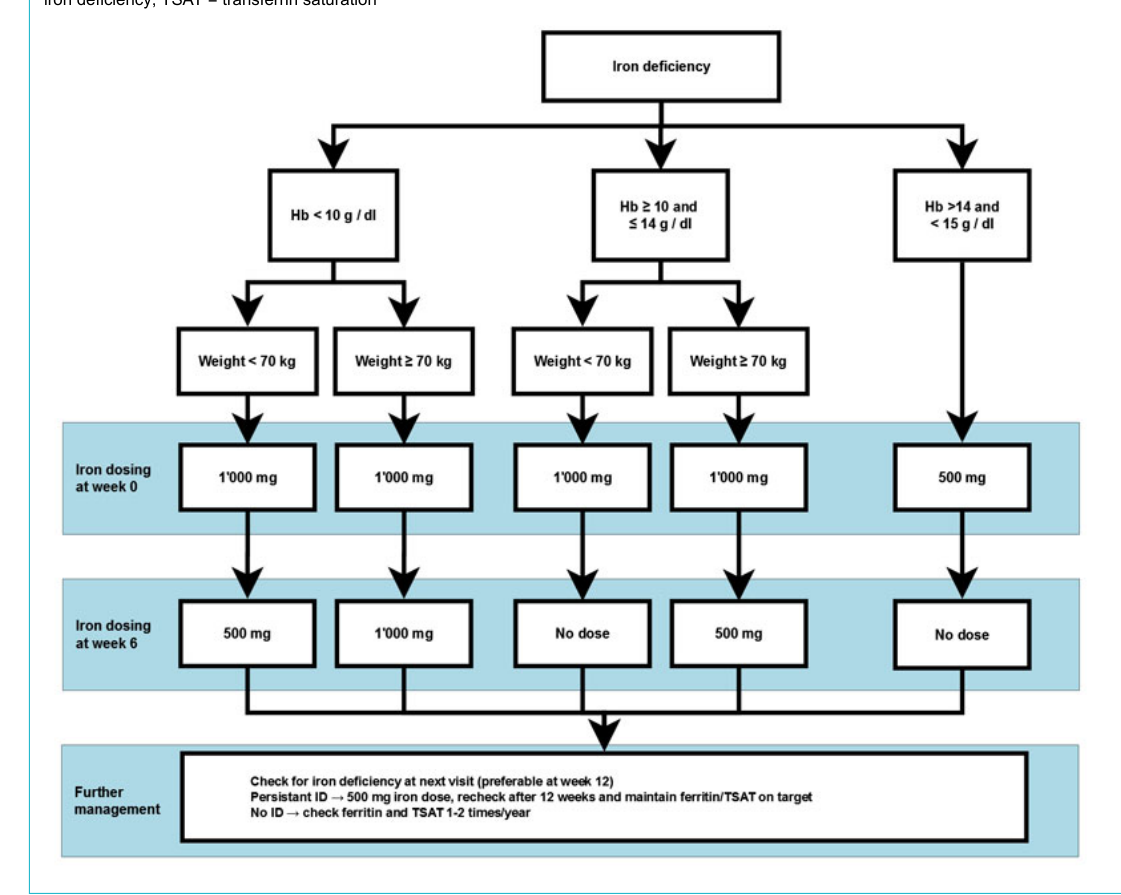
Figure 2: Clinical management of iron substitution in CHF patients. Dosing regimens are based on the CONFIRM-HF study [43, 44].Adapted from: Ponikowski P, et al. Beneficial effects of long-term intravenous iron therapy with ferric carboxymaltose in patients with symptomatic heart failure and iron deficiency. Eur Heart J. 2014;36:657–668 [51], with permission of the European Society of Cardiology.Hb = haemoglobin; ID = iron deficiency; TSAT = transferrin